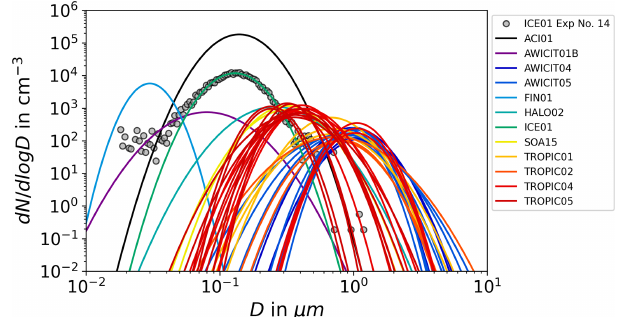
Figure 2. Number size distributions of H 2 SO 4 / H 2 O aerosol par- ticles. We show lognormal-fitted number size distributions for all AIDA experiments for which size information is available. The grey dots show an exemplary size distribution showing that a lognormal fit generally is adequate to accurately represent the measured size distribution (for details see Sect. 2.2).